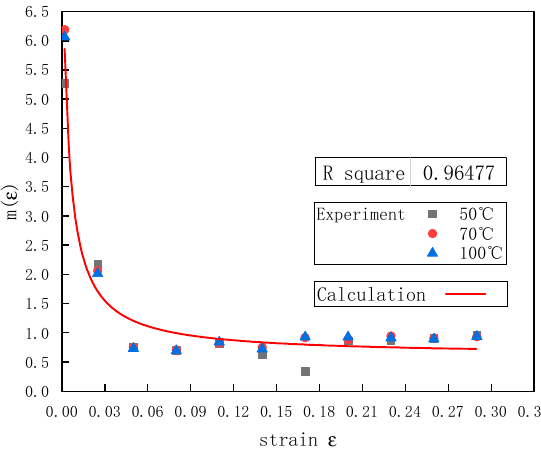
ε ) and ε at a strain rate of 1300 s − 1 and di ff erent temperatures. Figure 11. The relationship between 𝑚(𝜀) and 𝜀 at a strain rate of 1300 s ⁻ 1 and different temperatures. Figure 11. The relationship between m (